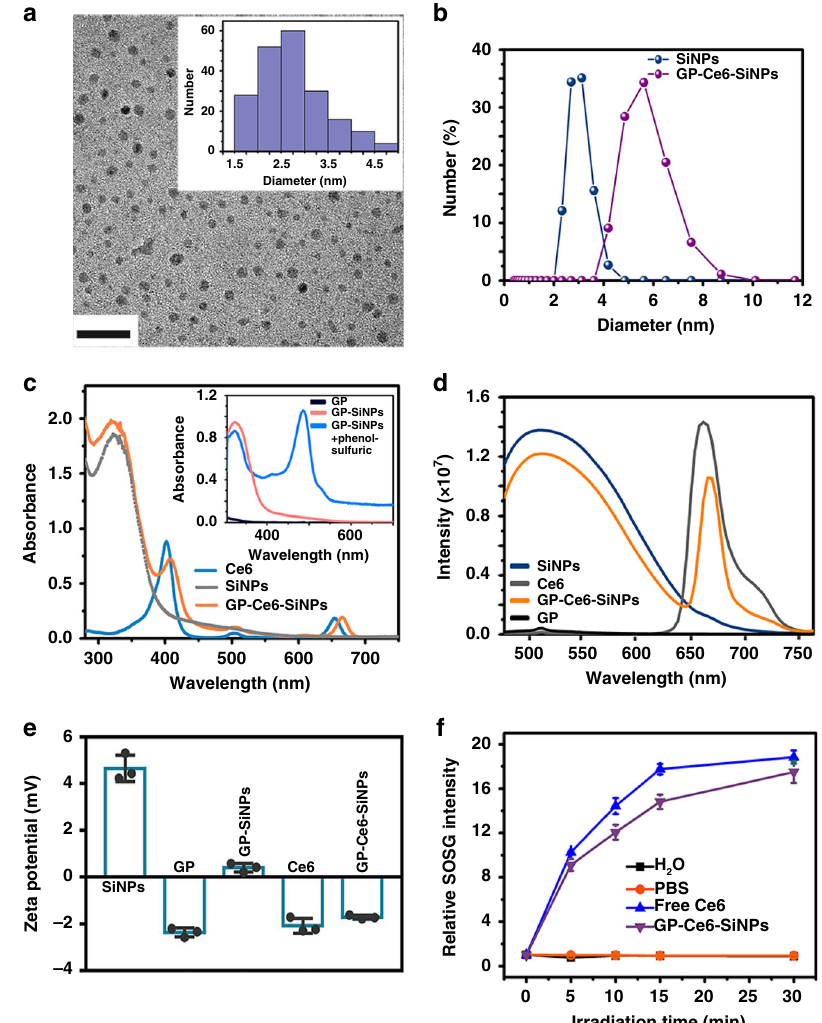
Fig. 2 Characterization of GP-Ce6-SiNPs. a TEM image and corresponding size distribution (inset) of GP-Ce6-SiNPs. Scale bar: 20 nm. b DLS spectra of SiNPs (blue curve) and GP-Ce6-SiNPs (purple curve). c UV-Vis absorbance of Ce6 (blue curve), SiNPs (gray curve), and GP-Ce6-SiNPs (orange curve). The inset image shows the UV absorbance of GP, GP-SiNPs, and GP-SiNPs treated with phenol-sulfuric acid (GP-SiNPs + phenol-sulfuric). d PL spectra of SiNPs (blue curve), Ce6 (gray curve), GP (black curve), and GP-Ce6-SiNPs (orange curve) ( λ ex = 405 nm). e Zeta potential of SiNPs, GP, GP-SiNPs, Ce6, and GP-Ce6-SiNPs. f 1 O 2 generation abilities of H 2 O, PBS, free Ce6, and GP-Ce6-SiNPs determined by using SOSG. Error bars represent the standard deviation obtained from three independent measurements. Source data are provided as a Source Data fi